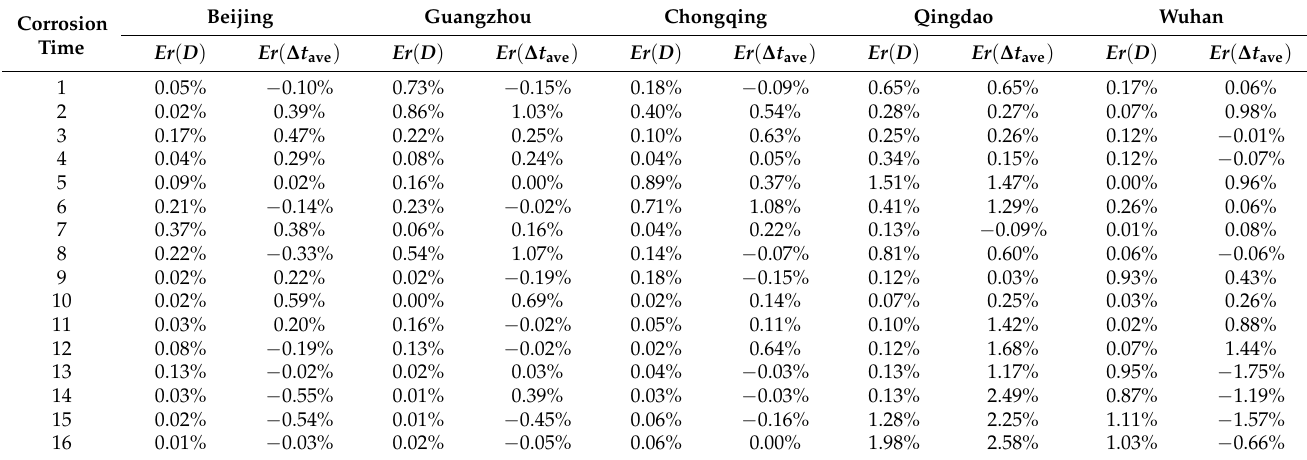
Table 2. Statistics of atmospheric corrosion simulation errors in representative areas.